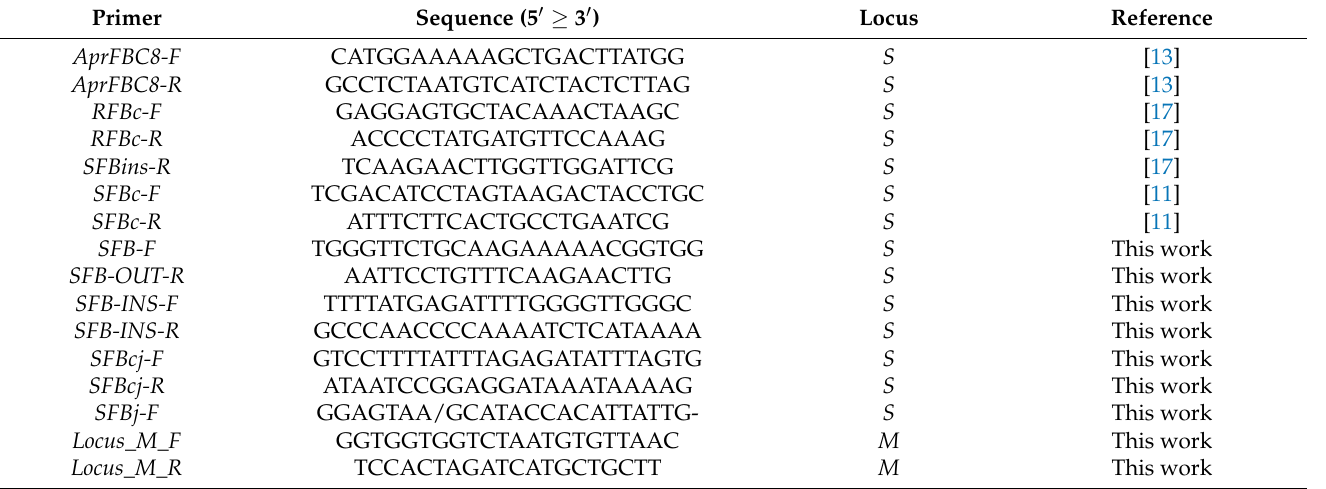
Table 2. Primers used in this